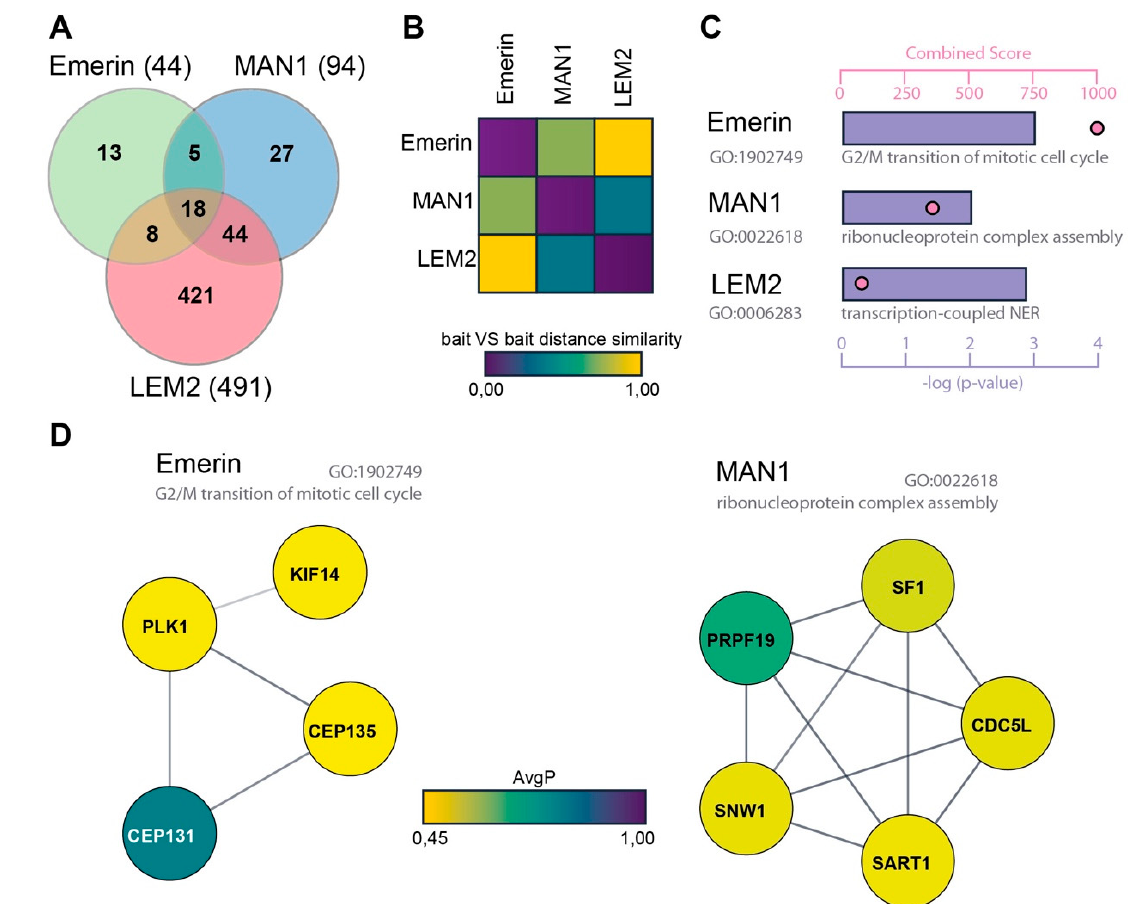
Figure 2. BioID identifies common and specific interactors for emerin, MAN1 and LAP2-Emerin-MAN1 (LEM2). Mass spectrometric data sets were analyzed using SAINT v. 2.5.0 [43,44] based on an average probability (AvgP) of ≥ 0.45. ( A ) Venn diagram showing the overlap of interactomes. Numbers indicate identified high-confidence interactors. ( B ) Bait vs. bait distance similarity analysis revealed a larger similarity between binding partners of MAN1 and LEM2 than the similarity of those proteins with emerin. ( C ) Gene ontology (GO) enrichment analysis using ENRICHR, considering a fold change ≥ 1 and p -value ≤ 0.05 [47]. ENRICHR identified enriched biological processes for each LEM protein. Blue bars represent p -value (log10) and pink points show GO term fold enrichment. ( D ) The identified interactors of emerin and MAN1 of indicated GO biological processes were further grouped and analyzed using the STRING database. The fill color of the nodes represents the AvgP and the line width represents the STRING